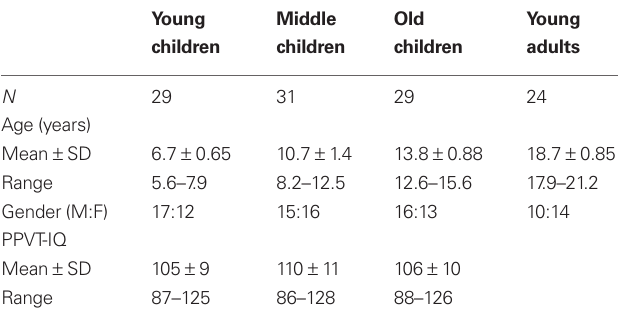
Table 1 | Demographic variables for each of the four age